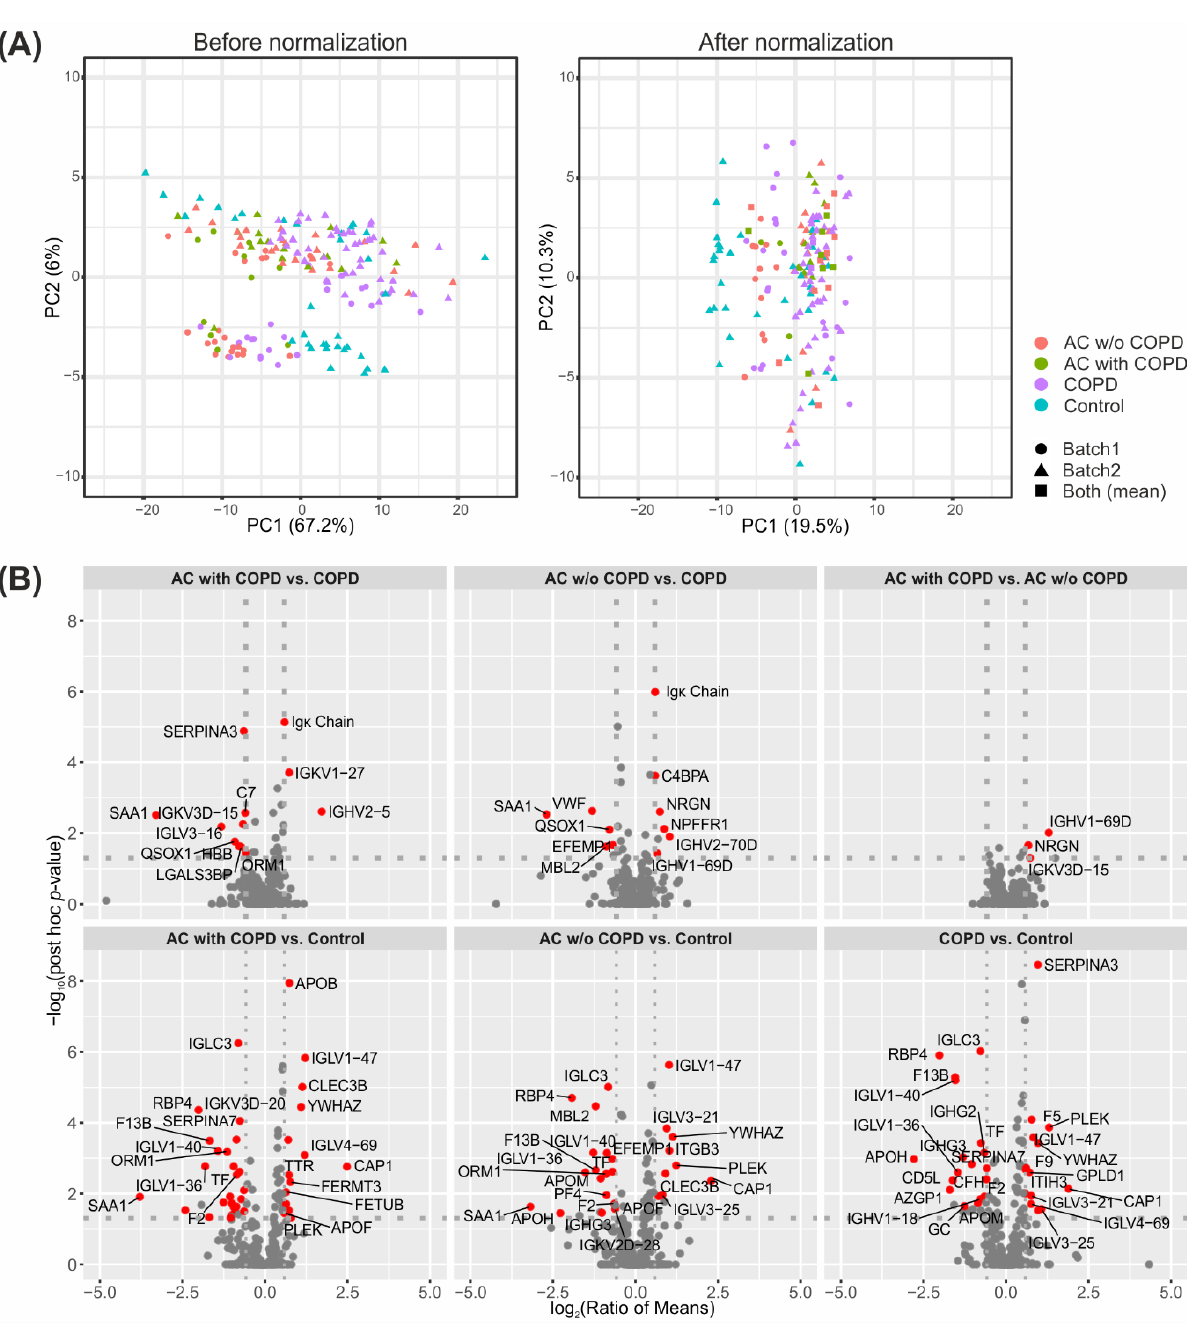
Figure 2. Normalization and statistical analysis of proteomics data. ( A ) Principal component analysis (PCA) plots of label-free LC – MS/MS data before and after batch normalization. Each data point corresponds to a sample measured in either batch 1, batch 2, or both batches (colors representing patient groups). ( B ) Volcano plots representing the results of statistical analysis using Welch-ANOVA. Significant proteins highlighted in red (ANOVA p FDR - value ≤ 0.05 (corrected according to Benjamini – Hochberg); post hoc p FDR - value ≤ 0.05 (corrected according to Bonferroni–Holm); absolute ratio of means ≥ 1.5) and labeled with gene names (except Igκ Chain).